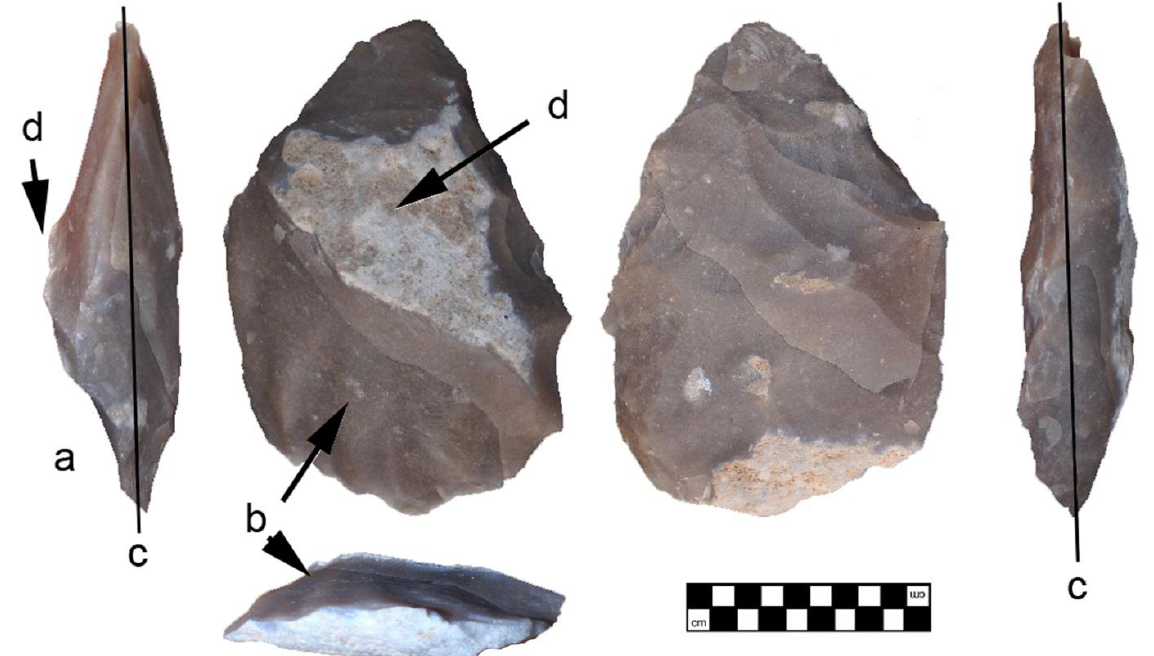
Figure 5. Replica 2 biface after overshot removal. a) removed mass; b) overshot flake scar; c) delineated biface plane; d) isolated central